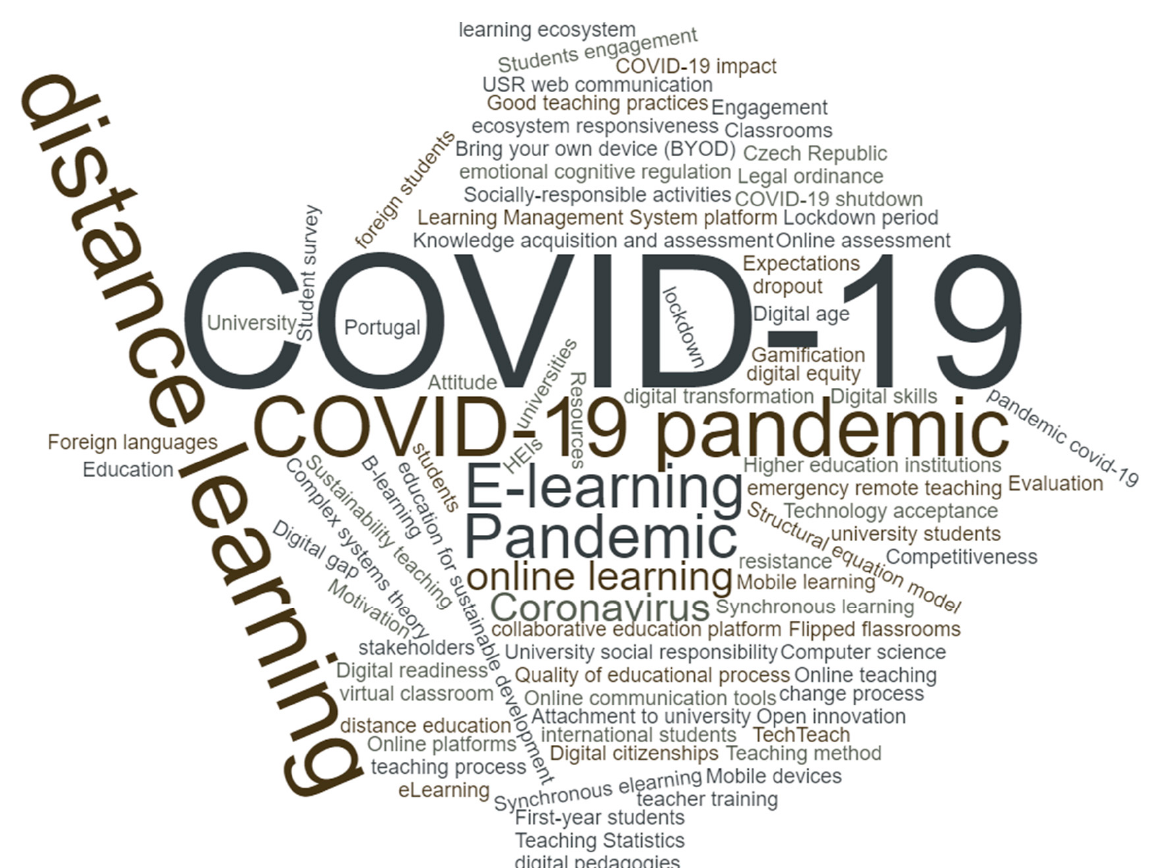
Figure 5. Cloud of keywords provided by the authors.